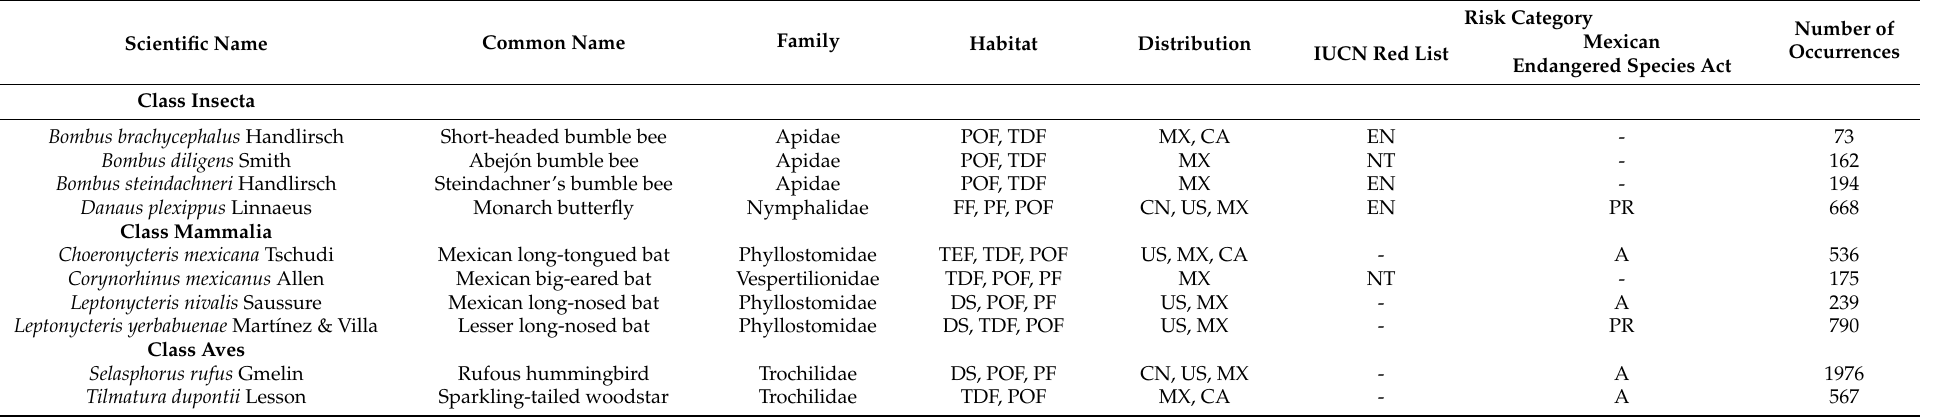
Table 1. Identity, habitat, distribution, risk category, and the number of occurrences of pollinator species potentially affected by the expansion of avocado monoculture in central